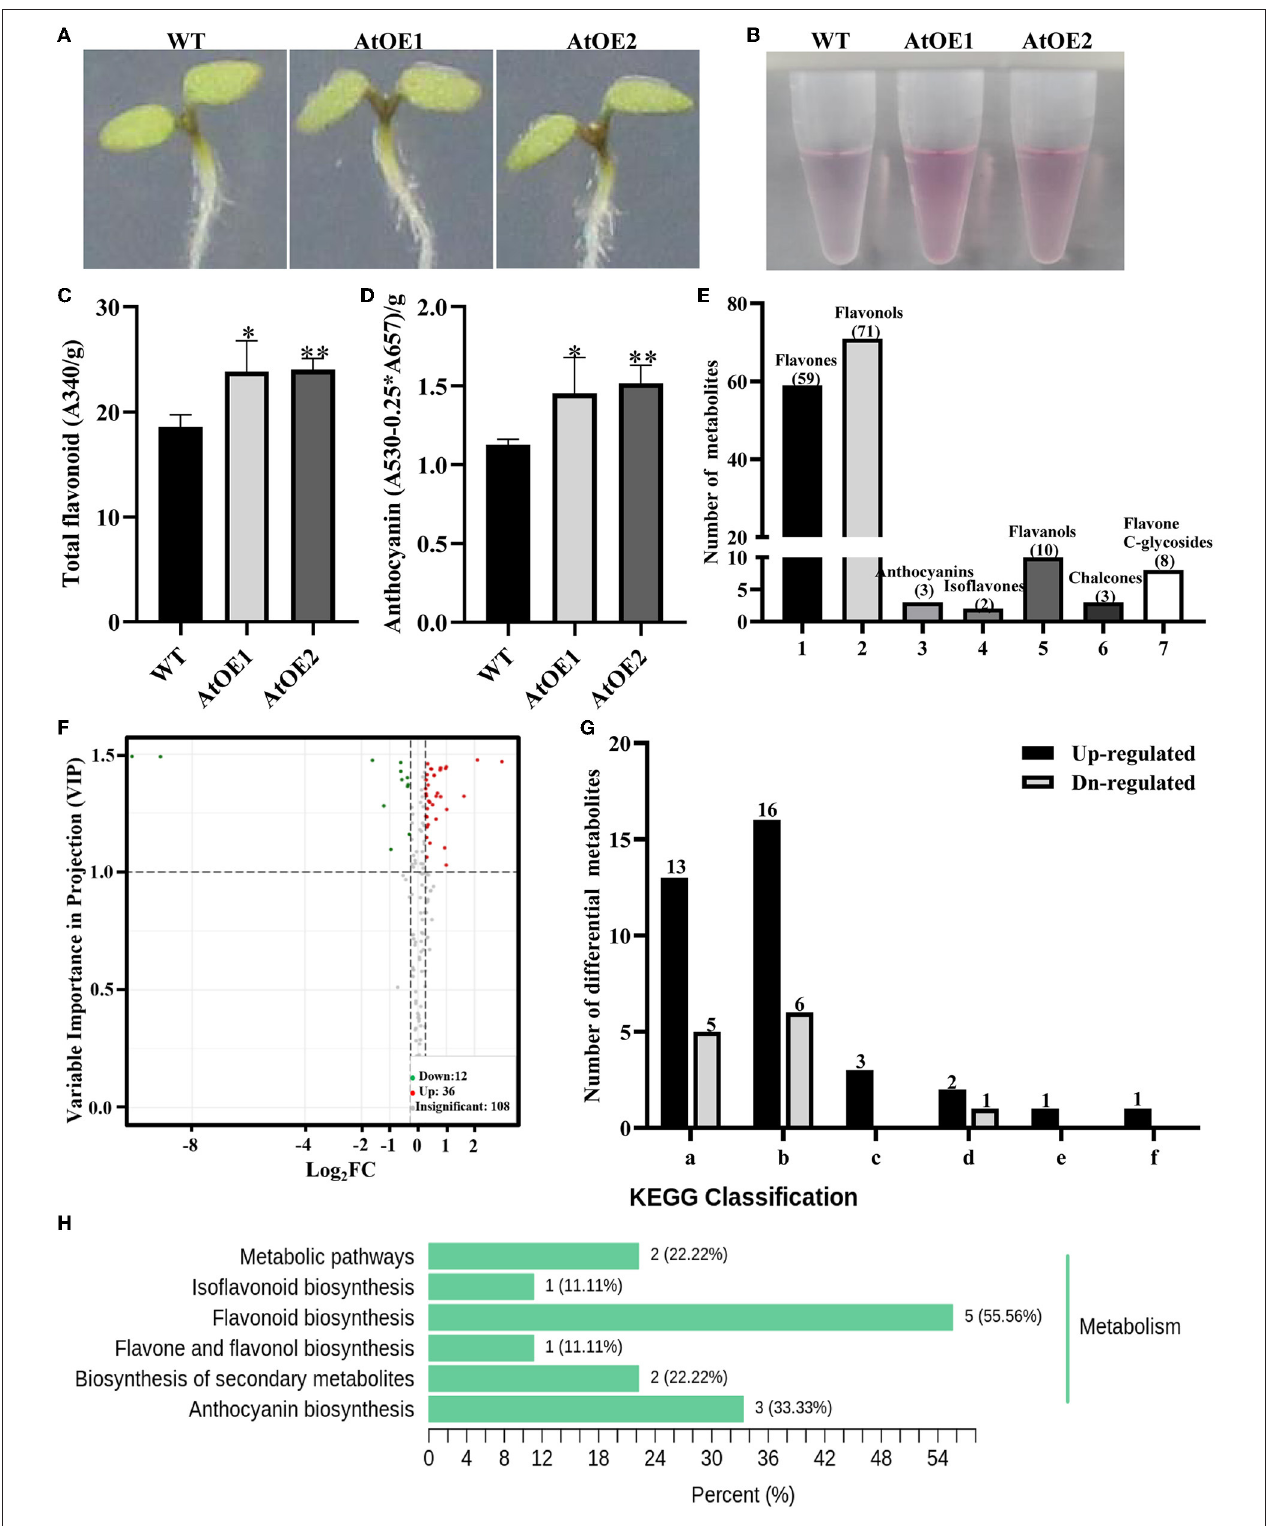
FIGURE 3 | Pn2-ODD1 increased the levels of flavonoids in 5-day-old Arabidopsis . (A) Anthocyanin accumulation visualized by the purple coloration in 5-day-old seedlings with constant light. (B) Anthocyanin extraction solutions for WT and AtOE lines. (C,D) Contents of total flavonoids and anthocyanins in 5-day-old seedlings detected by spectrophotometry analysis. (E) Number of different classes of flavonoids in 5-day-old WT and transgenic Arabidopsis detected by the flavonoids